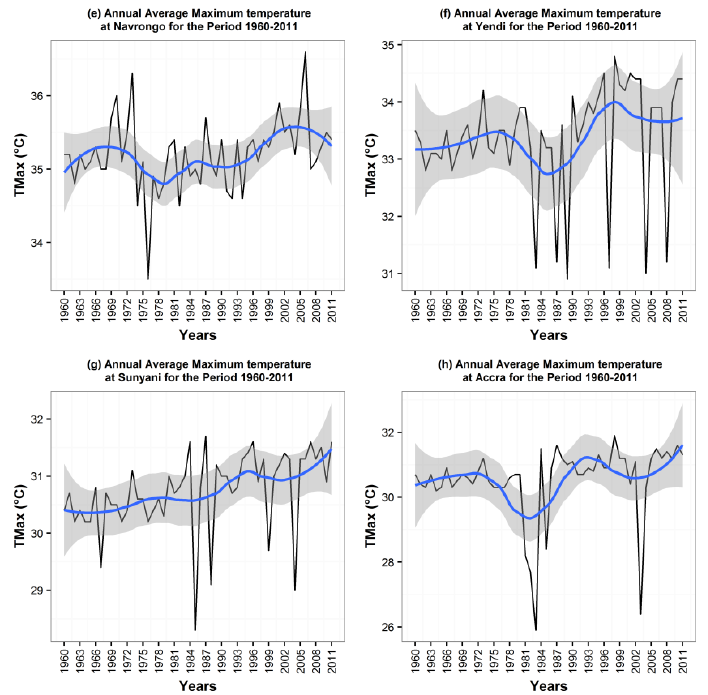
Figure 7. Maximum temperature time series of four selected stations in Ghana. The blue line or regression line represents a smoother. The grey band is the display of the confidence interval (95% confidence interval) around the